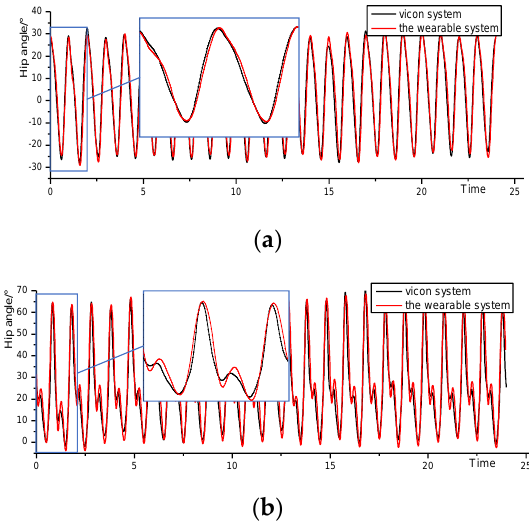
Figure 7. ( a ) Hip angle comparison curve; ( b ) Knee angle comparison curve.